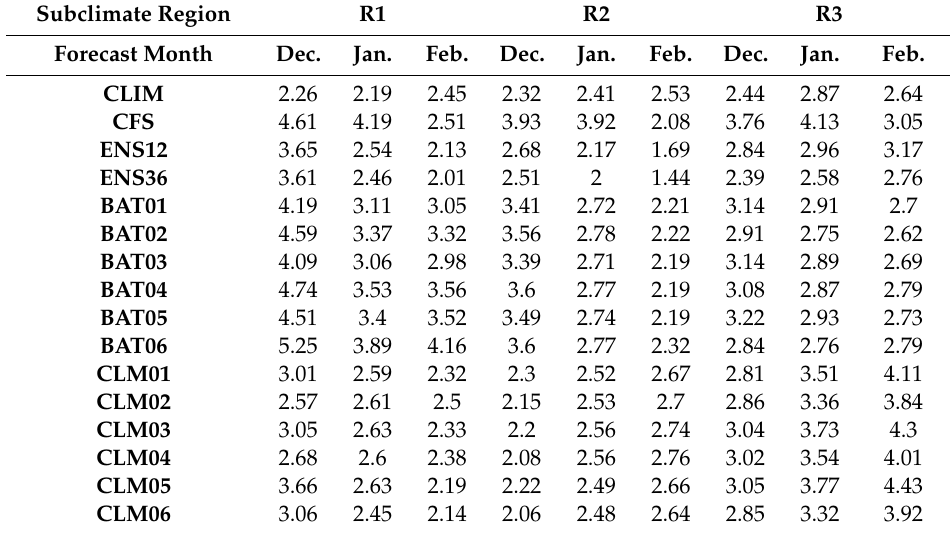
Table 2. Root-mean-square errors (RMSEs) in 1998–2018 for December, January, and February from CFS, ENS12, ENS36, and single forecasts for di ff erent subclimate regions at the four-month forecast range. The unit in ◦ C.